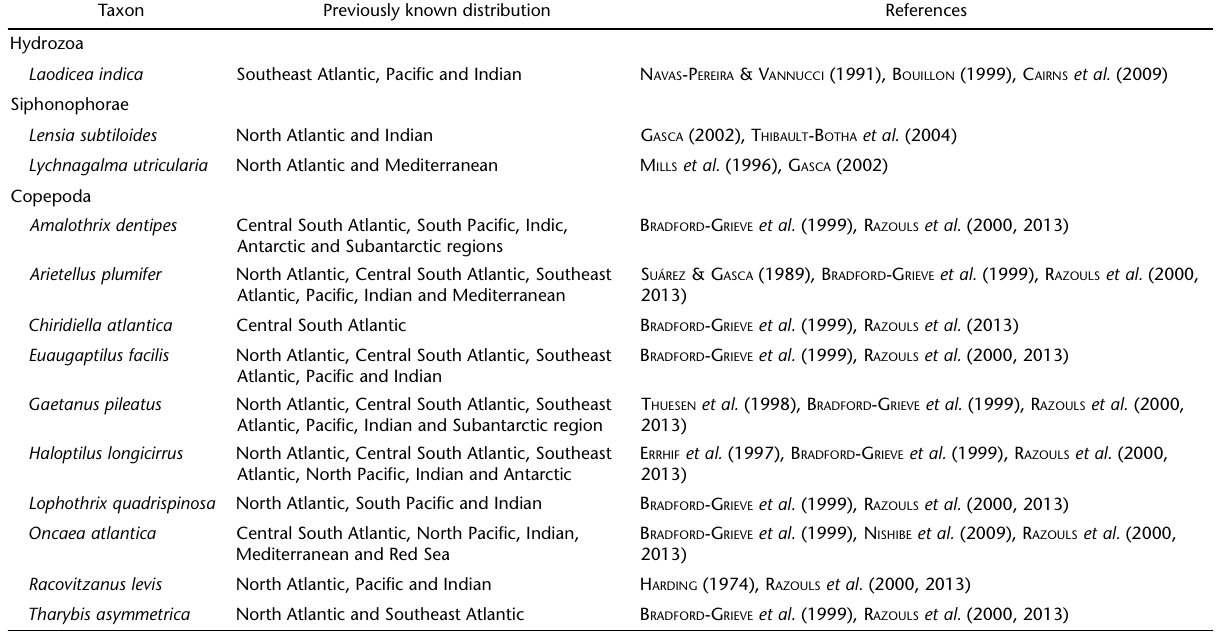
Table IV. New records for the southwest Atlantic of the mesozooplankton species collected in this study, with the previously known distribution.